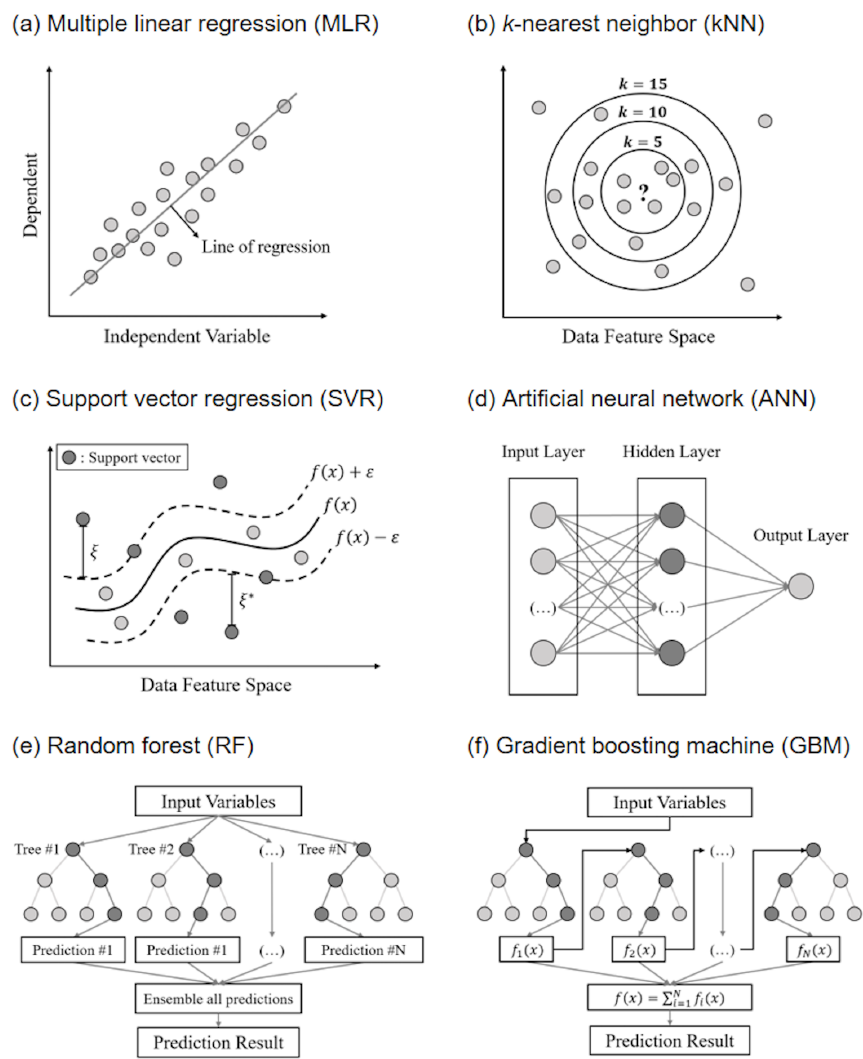
Figure 3. Schematic of each machine learning method: MLR (a) , kNN (b) , SVR (c) , ANN (d) , RF (e) , and GBM (f)